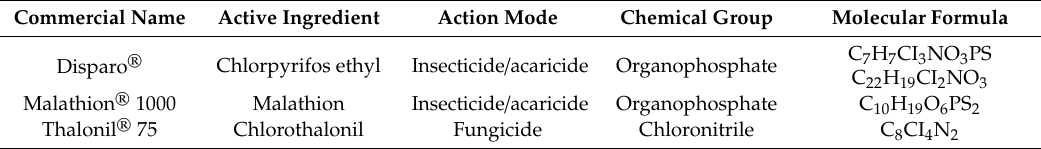
Table 1. Classification and characteristics * of agrochemicals used in the prickly pear pad study.